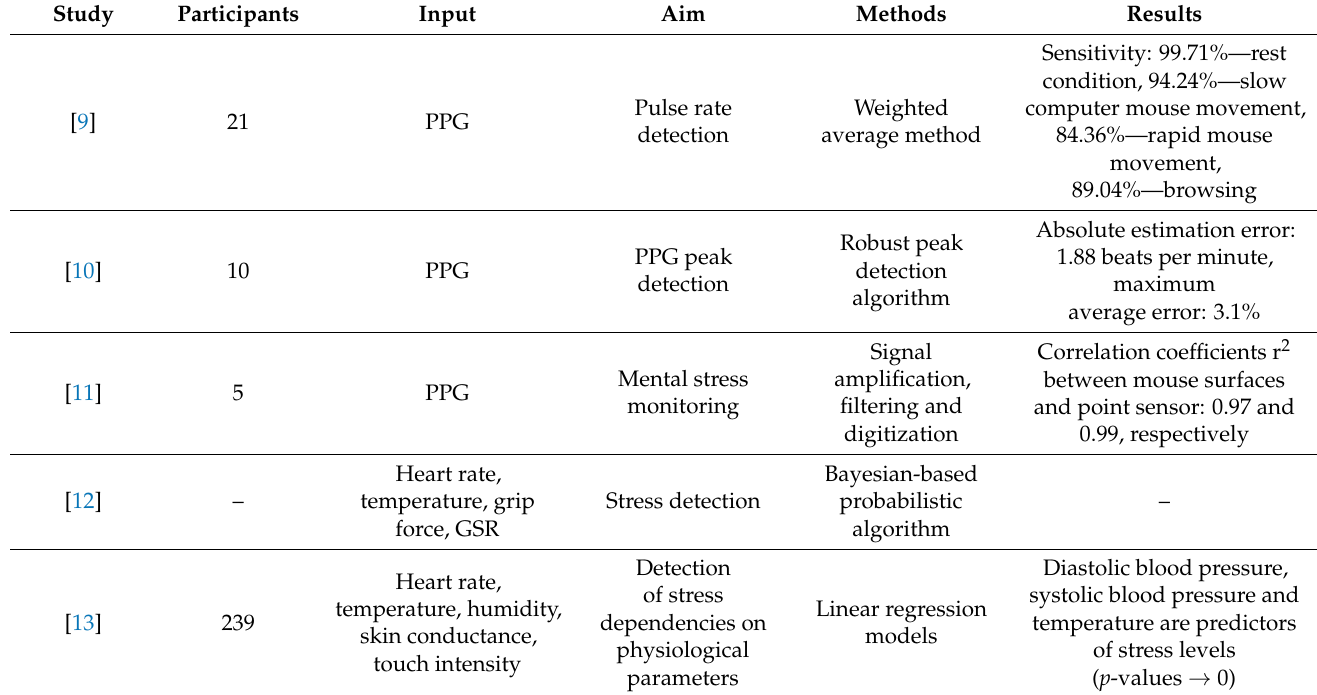
Table 1. Studies with sensor systems embedded in computer